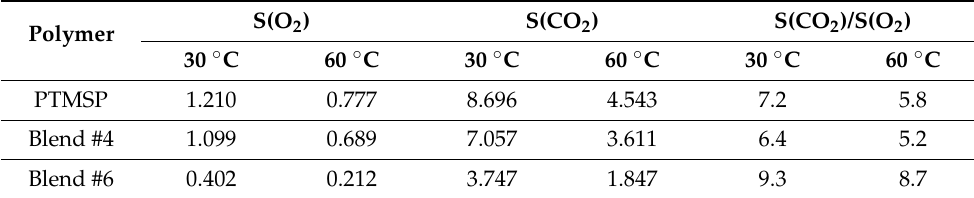
Table 4. Solubility coefficients (Henry’s constants) of oxygen and carbon dioxide in PTMSP